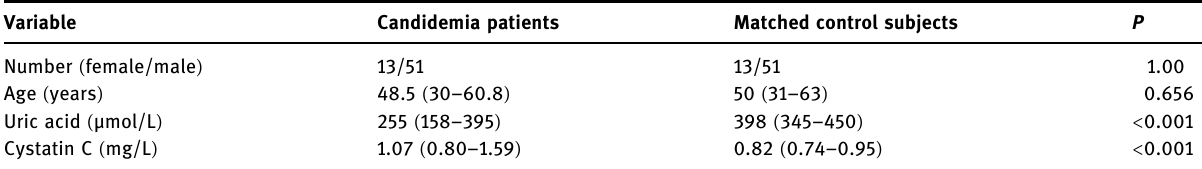
Table 2: Serum uric acid and cystatin C concentrations of patients with candidemia and healthy control subjects Variable Candidemia patients